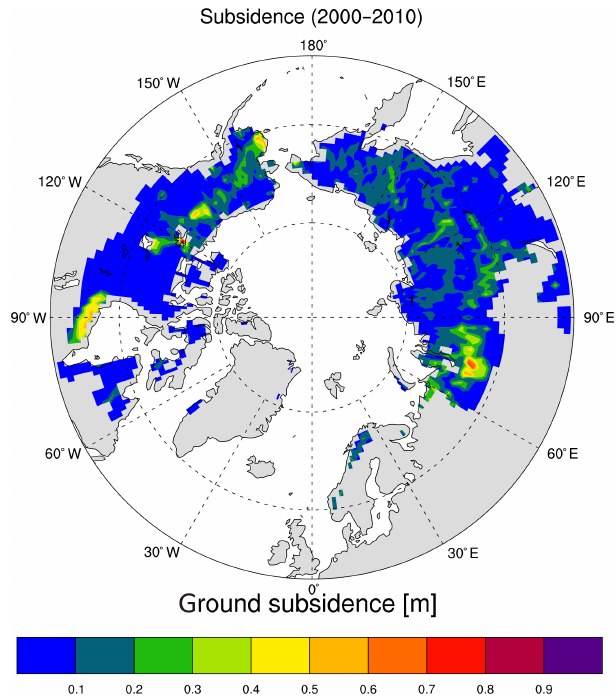
Figure 3. High-latitude ( > 50 ◦ N) map of ground subsidence simu- lated from the Exice experiment averaged for the period